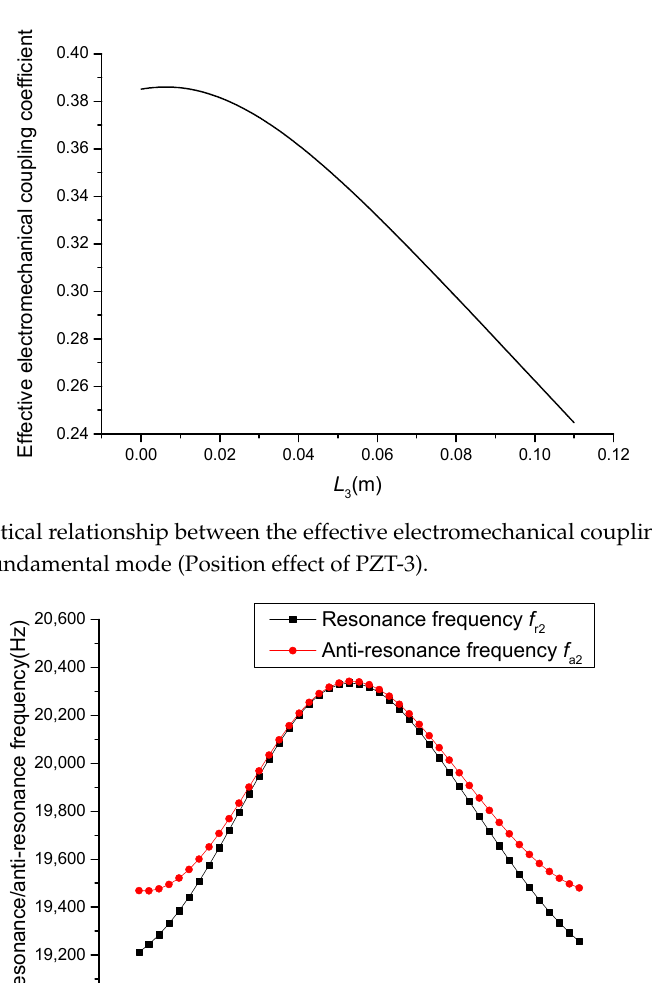
Figure 11. Theoretical relationships between the resonance/anti-resonance frequencies and length L at the fundamental mode (Position effect of PZT-3).